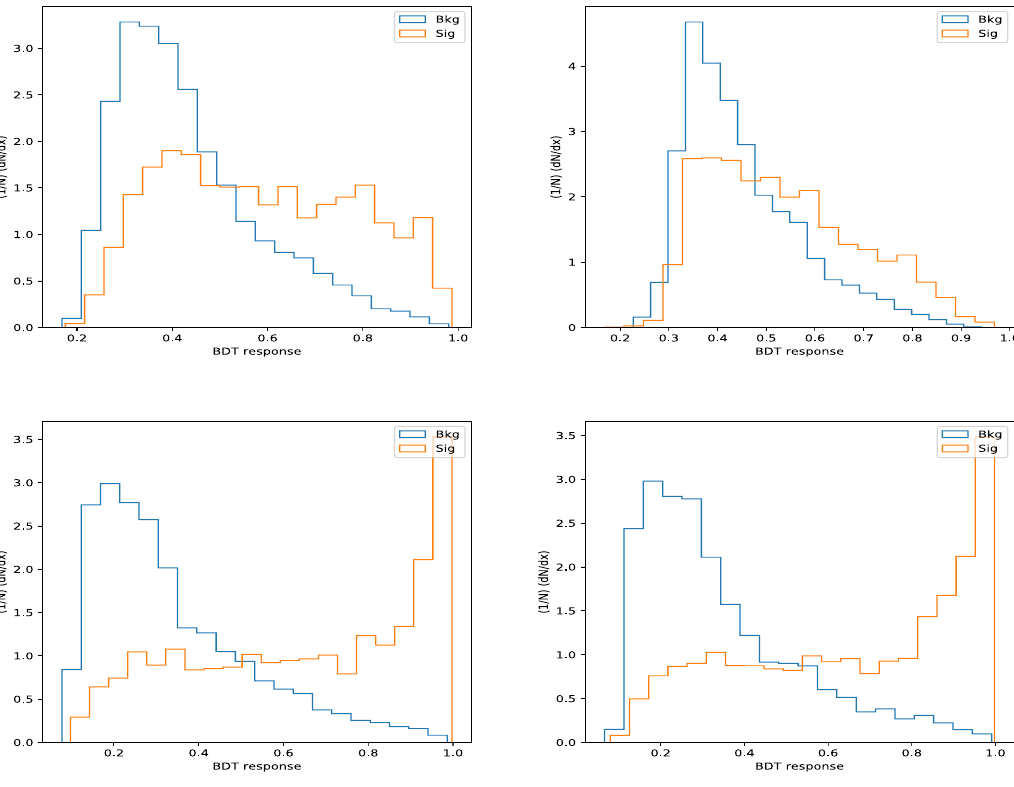
Figure 16 . BDT classifier response for different benchmark points of gluon fusion for Type I BP I (top left), Type I BP II (top right), Type II BP I (bottom left) and Type II BP II (bottom right).